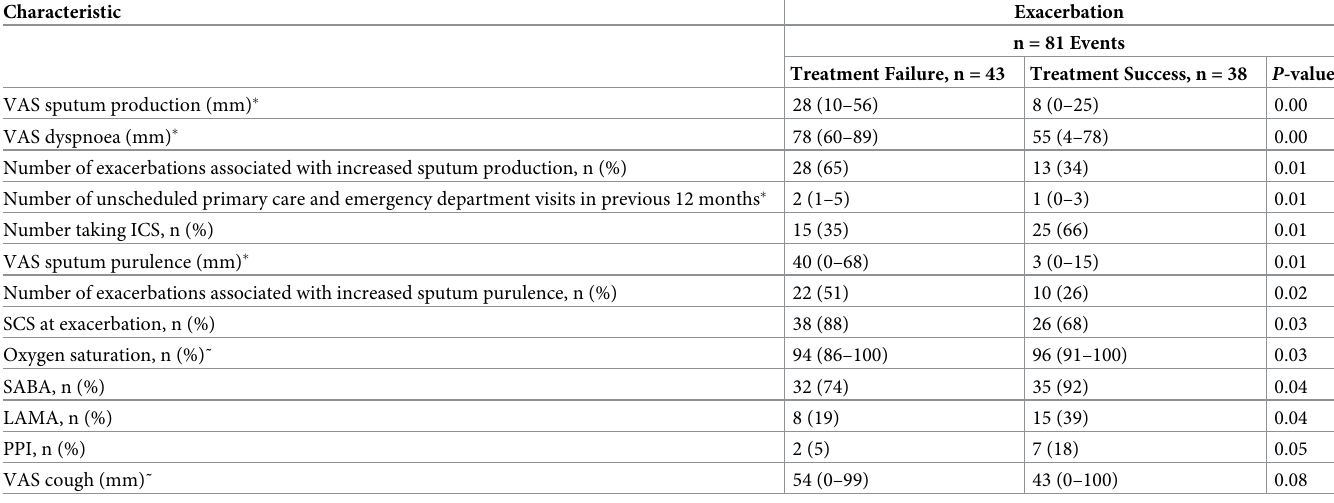
Table 4. Comparison of D0 exacerbation characteristics of patients who failed treatment with those who succeeded treatment which p < 0.1 (see S1 Appendix for all other characteristics evaluated).